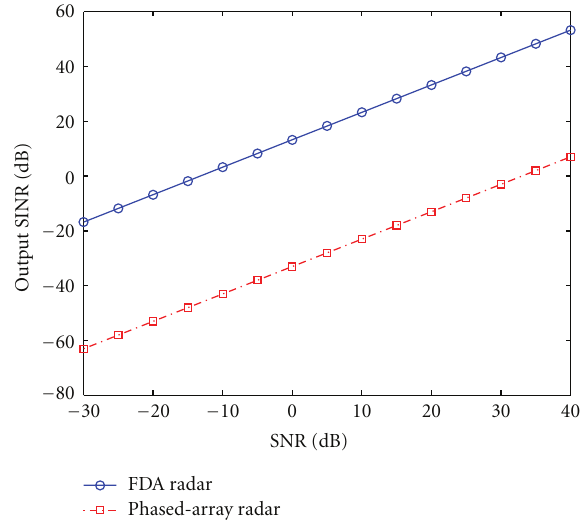
Figure 11: The comparative output SINR versus SNR at a fixed INR =